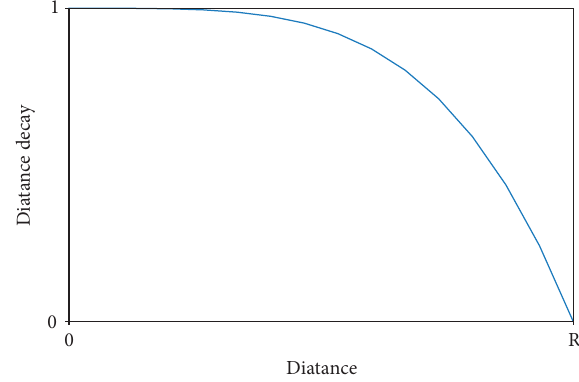
Figure 10: Distance decay function.